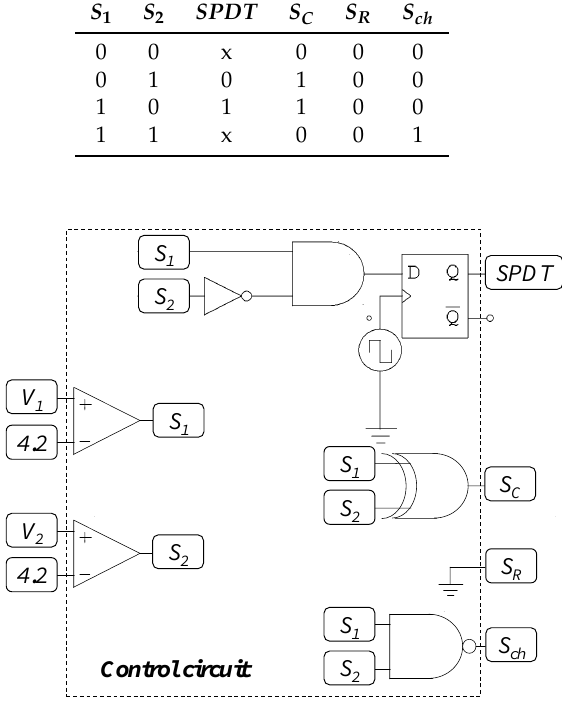
Table 1. Truth table of the switches in resistor-based mode of operation.